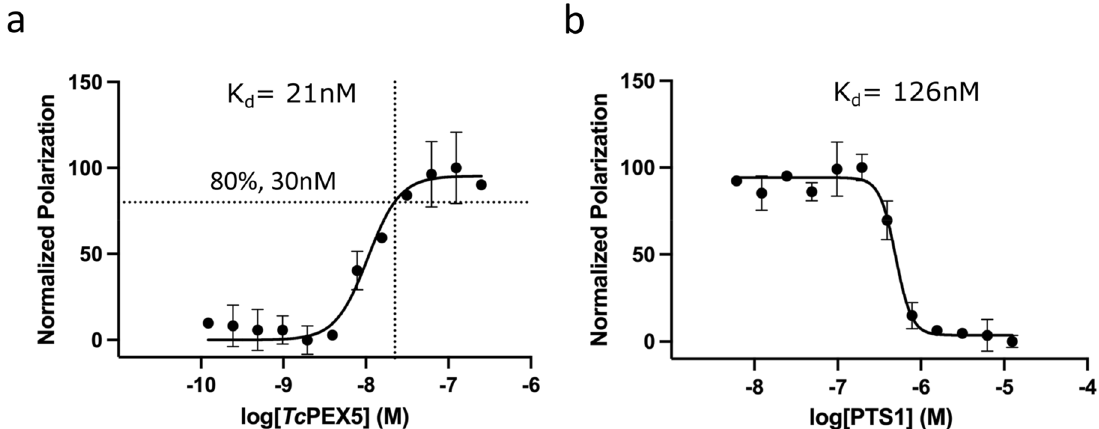
Figure 2. Fluorescence polarization (FP) based PEX5–cargo interaction assay. ( a ) PTS1 (10 nM, 6-FAM labeled) was titrated with Tc PEX5 (TPR domain) and changes in the polarization of emitted light were monitored. Affinity (K d ) was determined by curve fitting. f 0 point was determined at 30 nM Tc PEX5. ( b ) Competitive FP assay—increasing concentrations of unlabeled PTS1 were added to 30 nM Tc Pex5 (f 0 ) and 10 nM labeled PTS1 mixture and the changes in the polarization of emitted fluorescence were monitored. K i was determined by curve fitting. ( a , b ) Each data point represents an average of three independent measurements with the standard deviation indicated. Polarization values were normalized by setting the average FP readout for the free FAM-PTS1 at 0% and the average FP value for PEX5 saturated FAM-PTS1 at